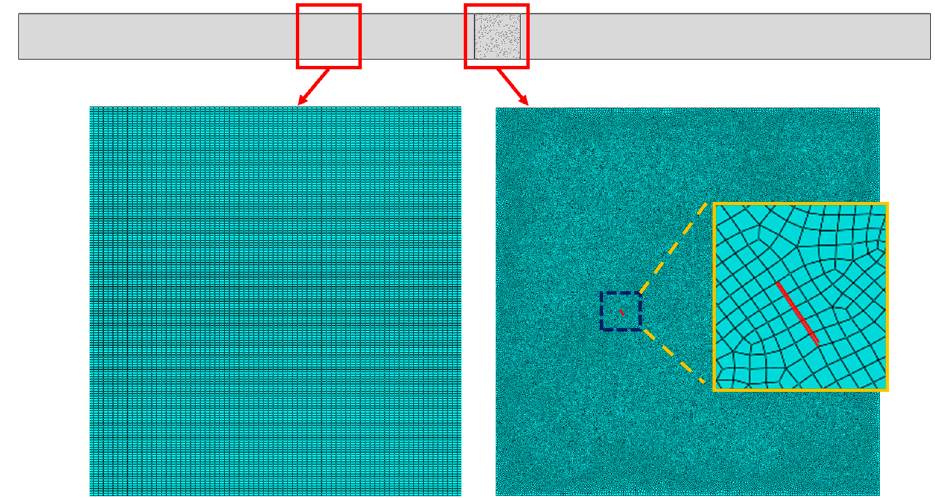
Figure 2. Finite element model (FEM) of the micro-crack region: the distribution of micro-cracks and finite element mesh (the red line represents one crack in the micro-crack region, L 1 = 40 mm, L 2 = 4 mm, L 3 = 36 mm).